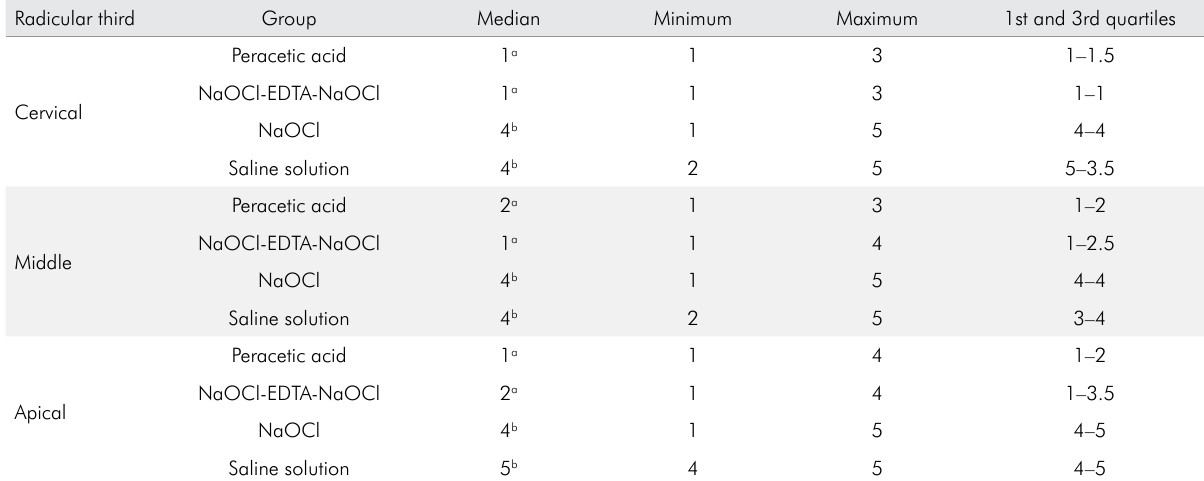
Table 1. Smear layer evaluation after root canal preparation using different irrigant solutions. Radicular